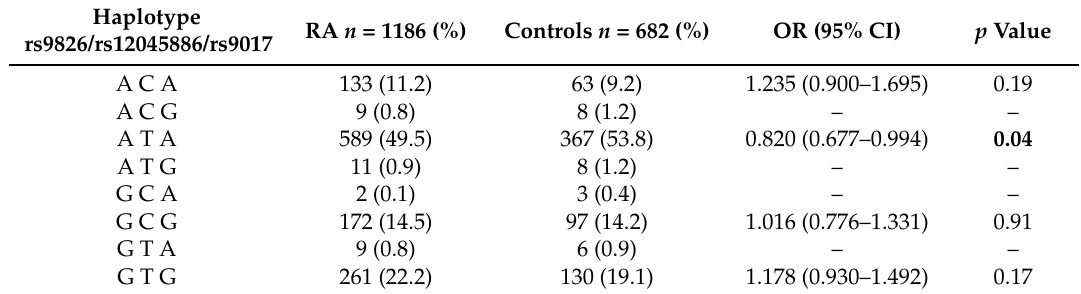
Table 3. RORc2 haplotypes in RA patients and